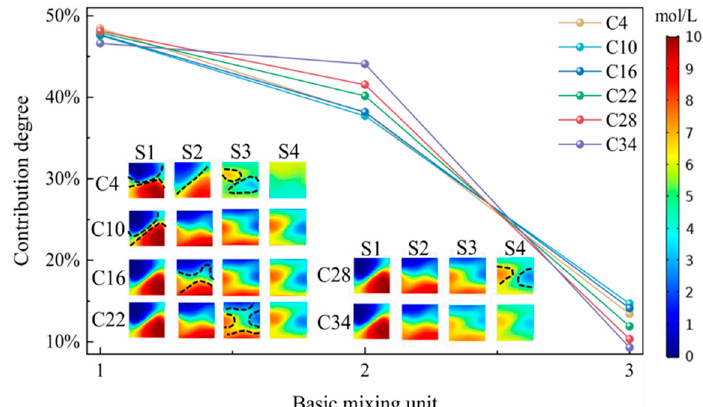
Figure 8. Contribution degree of basic mixing unit to mixing under working conditions C4, C10, C16, C22, C28 and C34 and sectional concentration distribution nephogram under corresponding working conditions.